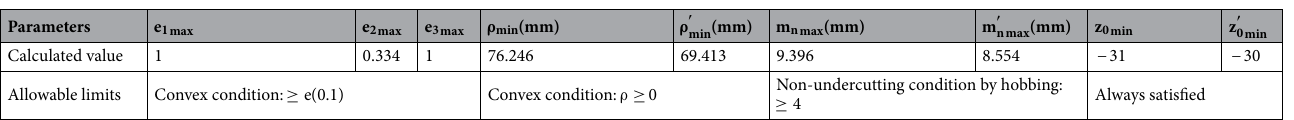
Table 2. Parameters for